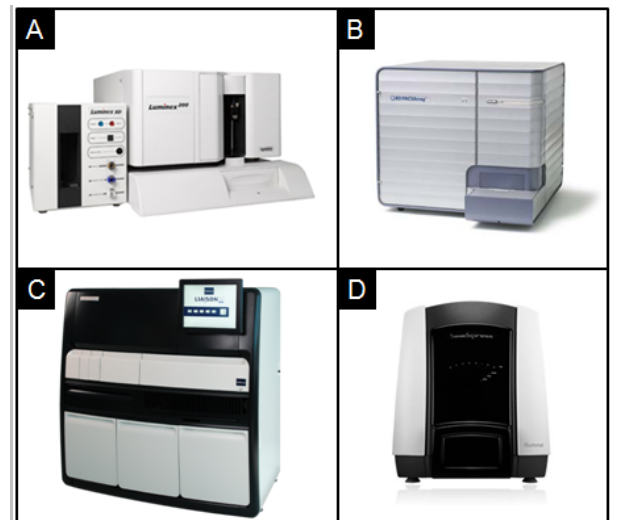
Figure 1. Current solid-state bead-based clinical laboratory analyzers include the ( A ) Luminex 100/200, ( B ) BD FACSArray, ( C ) Diasorin Liaison, and ( D ) Illumina